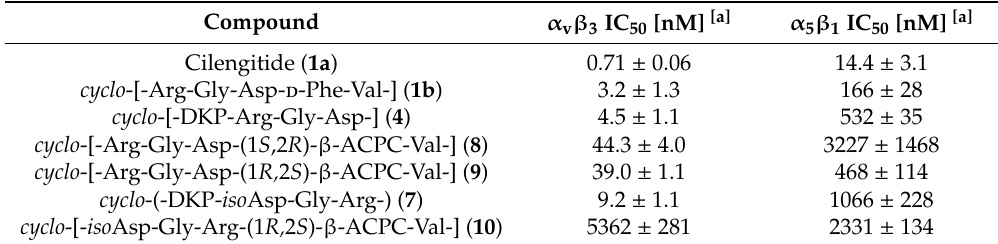
Figure 2. Cyclic peptidomimetics containing cis - β -ACPC scaffolds. Table 1. IC 50 values measured from competitive binding assays to α v β 3 and α 5 β 1 integrins.